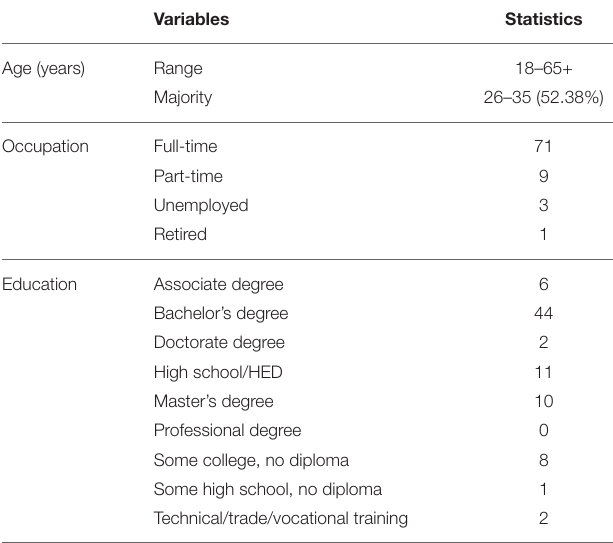
TABLE 5 | MTurk participant demographics. TABLE 6 | GMSI range, median, mean, and standard deviation.